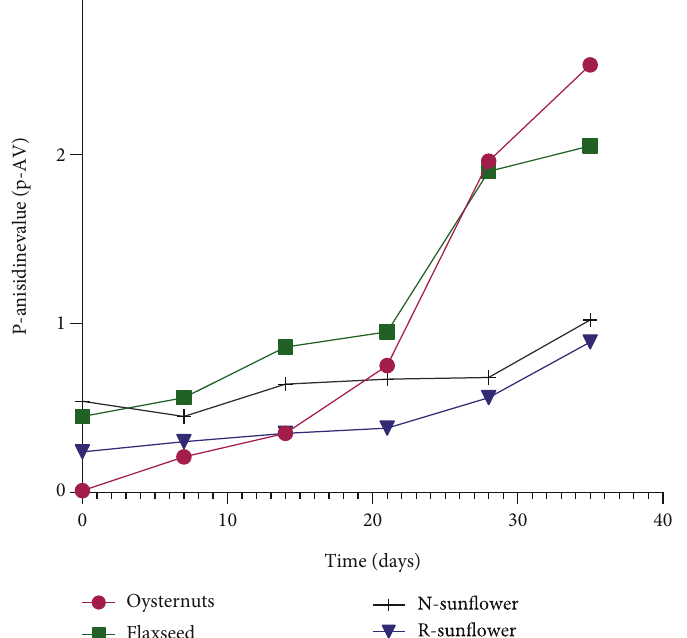
Figure 4: Line graphs showing variations in p-anisidine values (p-AV) of oyster nut oil, fl axseed oil, nonre fi ned sun fl ower oil, and re fi ned sun fl ower oil samples stored at 27 ° C for 40